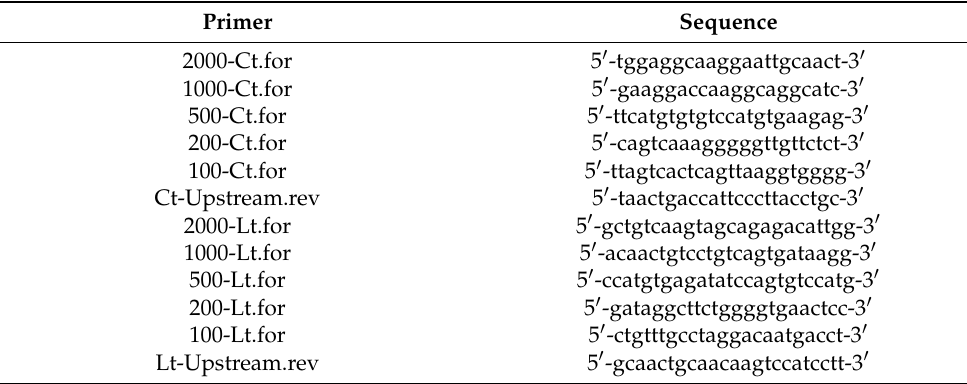
Table 1. Primers used for the cloning of the respective reporter gene constructs.